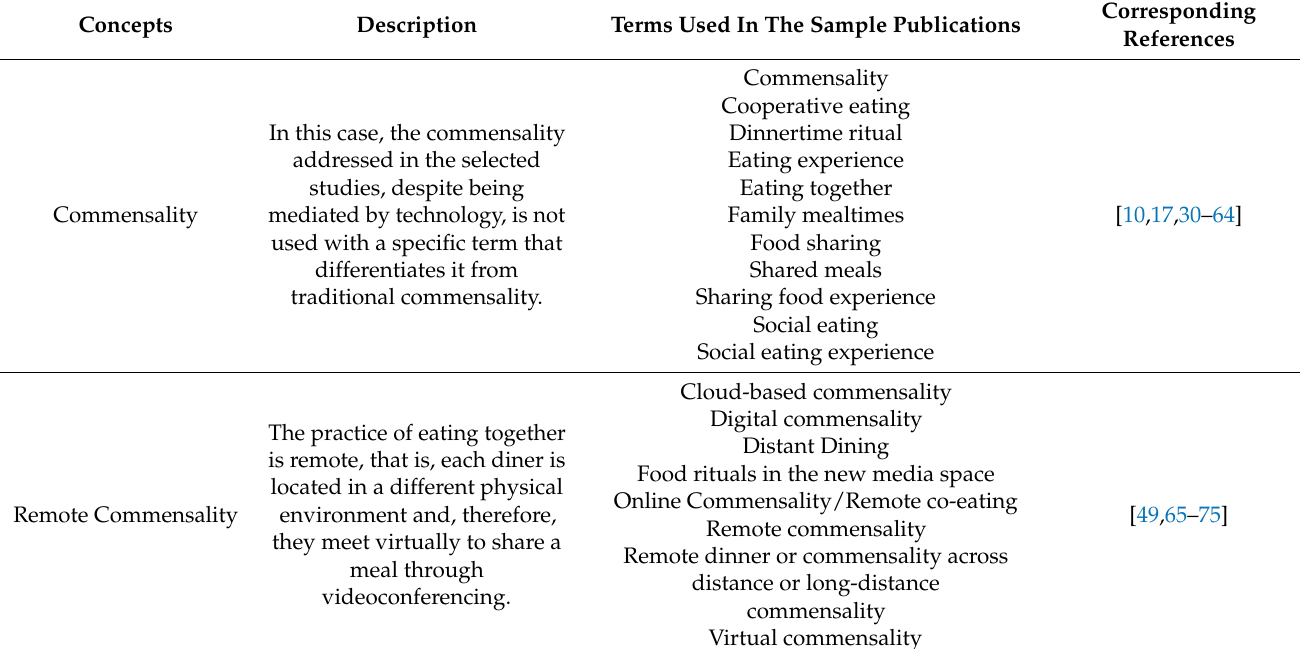
Table 1. Terms used in publications to characterize new forms of